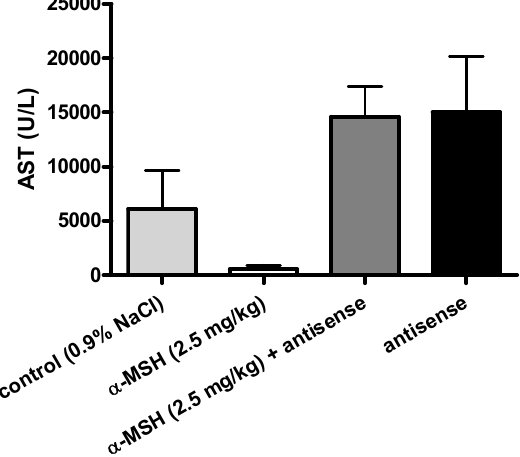
Figure 6. Modulation of α -MSH induced hepatoprotection by means of its antisense pentapeptide LVKAT. Aspartate aminotransferase activity (AST) in plasma of the control and treated animals 24 h after acetaminophen